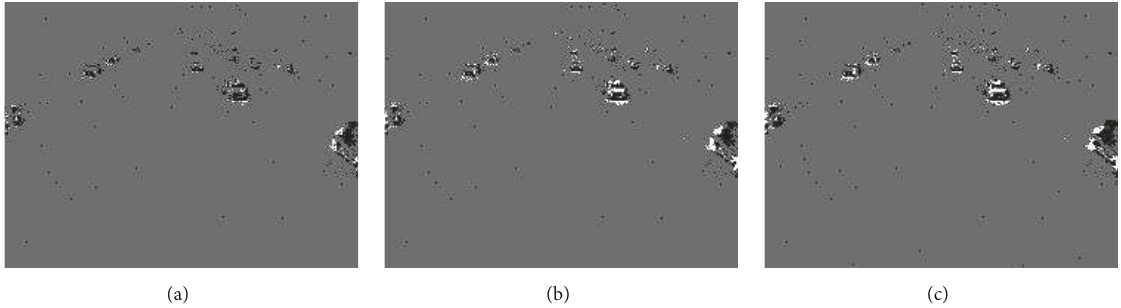
Figure 3: (a) Events accumulated in 10ms time interval. (b) Events accumulated in 20ms time interval. (c) Events accumulated in 30ms time interval.